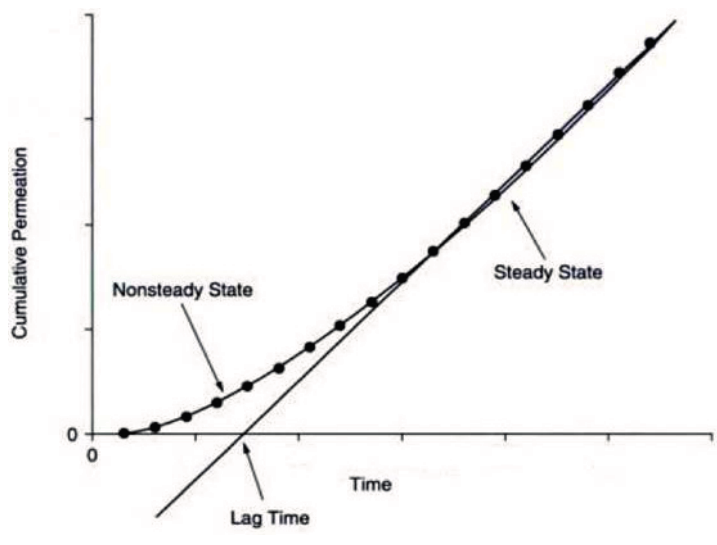
Figure 4. A typical plot of permeation